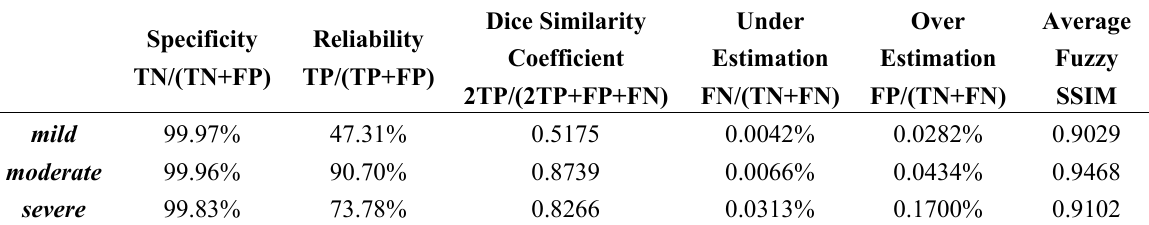
Figure 10. ( a ) An MSE comparison of the estimated fuzzy label mask to the ground truth for mild MS lesion data. ( b ) An SSIM comparison of the same fuzzy masks. Table 3. Comparisons measures for the discrete and fuzzy labels of MS lesion voxels across the entire brain ROI of the mild, moderate and severe MS lesion brain data, based on the results in Table